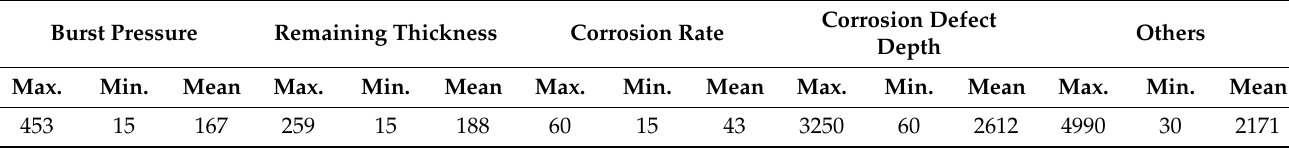
Table 7. The data size of prediction models.